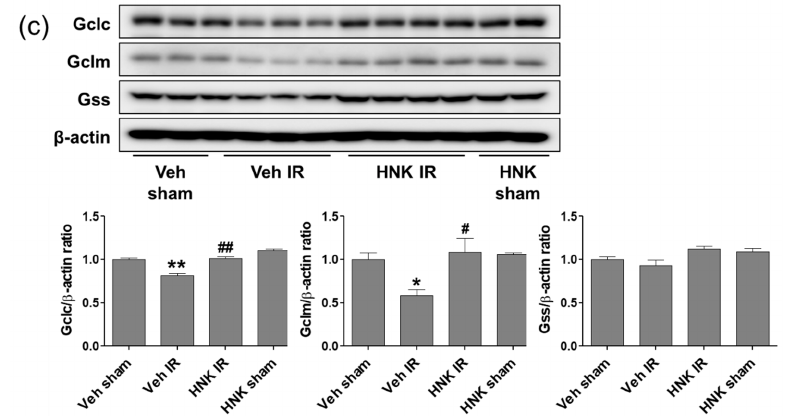
Figure 7. Honokiol attenuates the lipid peroxidation by increasing the expression of GSH biosynthetic enzymes in the kidney of IR ‐ subjected mice. C57BL/6 mice were subjected to 25 min of bilateral renal ischemia. Honokiol (1 mg/kg) or vehicle was injected twice, 1 h prior to ischemia and 4 h after reperfusion. The kidney tissues were collected at 24 h of reperfusion. ( a ) Representative images of 4 ‐ HNE staining of renal sections to evaluate the lipid peroxidation. ( b ) The mRNA expression of Gclc, Gclm, and Gss was determined in kidney tissues by real ‐ time PCR analysis. Relative mRNA levels were normalized to those of GAPDH. ( c ) The protein expression of Gclc, Gclm, and Gss was determined in the kidney tissue lysates using Western blot analysis. Relative protein levels were normalized to those of β‐ actin. Values are expressed as the means ± S.E.M. of 4–8 mice from each group. * p < 0.05, ** p < 0.01 significant compared with Veh sham. # p < 0.05, ## p < 0.01 significant compared with Veh IR.